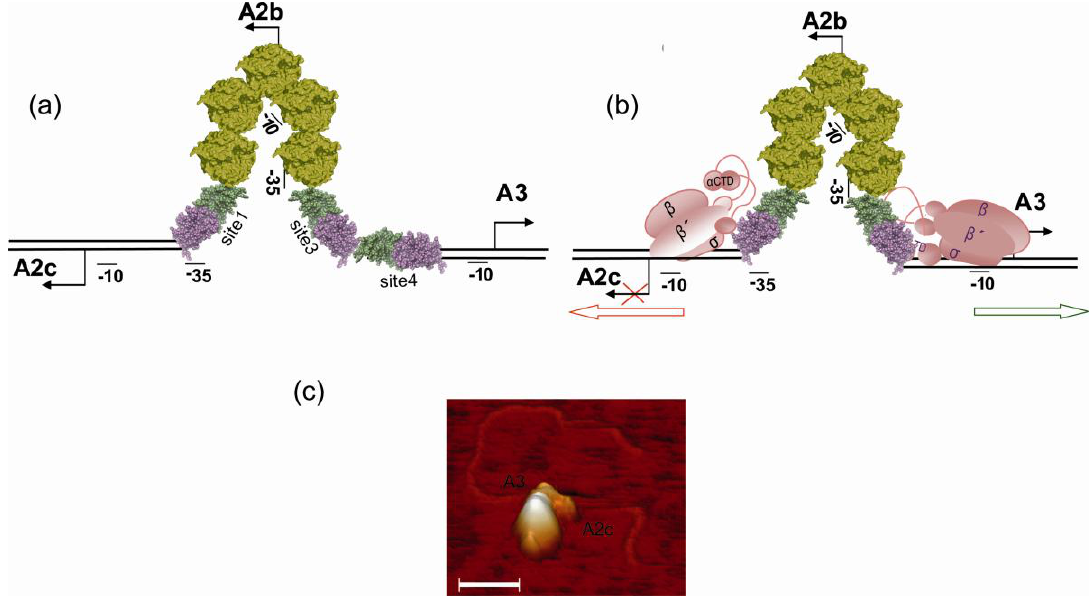
Figure 4. Model and Atomic Force Microscopy (AFM) images representing the hairpin on the p4-p6-DNA and on the p4-p6-RNAP-DNA complexes. ( a ) Localization of proteins and topology of the DNA on the ternary p4-p6-DNA complex. Protein p4 (dimer in violet-green) and protein p6 (dimer in yellow) binding between promoters A2c and A3 results in the formation of the nucleoprotein-hairpin. P4 bound to sites 1 and 3 partially overlay the −35 elements of early promoters A2b and A2c, respectively; ( b ) Model of the p4-p6-RNAP-DNA quaternary complex. The RNAP is represented stably bound to promoter A3 but in an unstable interaction with promoter A2c; ( c ) AFM image of a quaternary complex p4-p6-DNA-RNAP. The image shows the large volume of the RNA polymerase bound to promoter A3 and to its right the hairpin structure originated by the binding of p4 and p6 to the